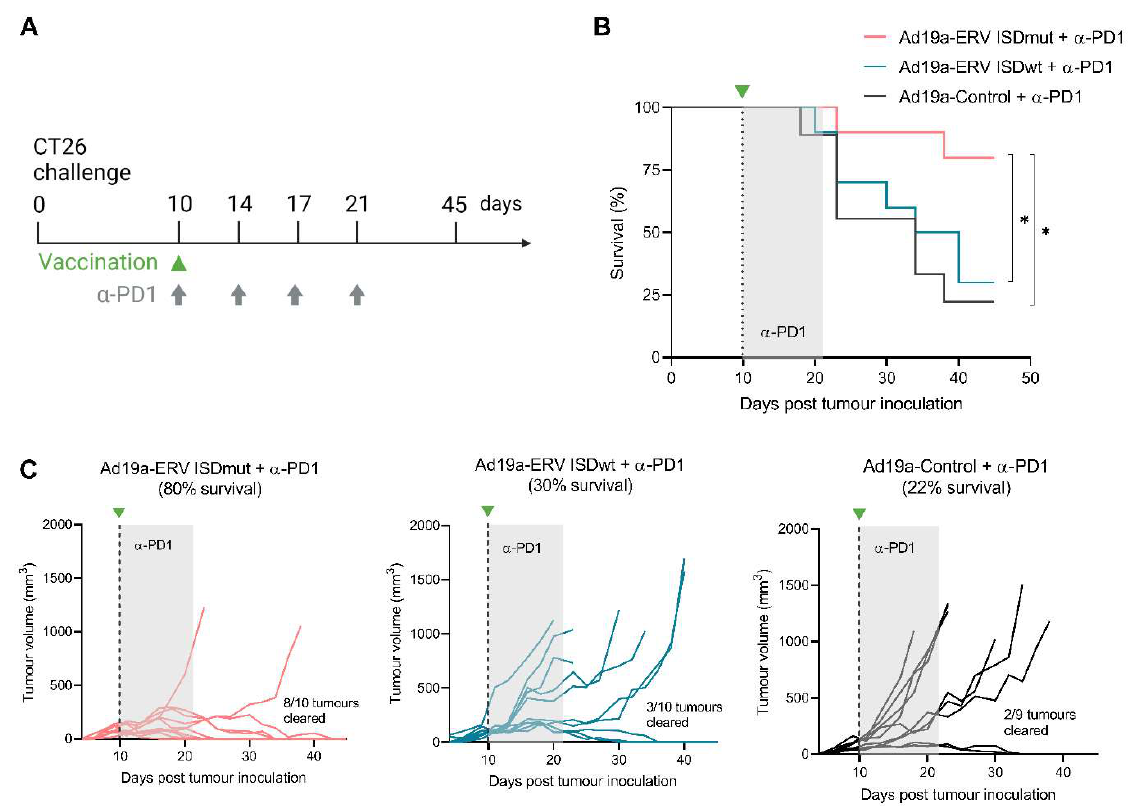
Figure 4. Ad19a/64-ERV ISDmut synergises with α -PD1 check point inhibitor and eradicates established colorectal tumours in mice . ( A ) Schematic representation of the tumour challenge and the therapeutic treatment. BALB/c mice were challenged s.c. (right flank) with 5 × 10 5 CT26 cells and tumour size was evaluated every 2–3 days. Mice were randomized and vaccinated s.c. (left paw) on day 10 with either the Ad19a/64-ERV ISDwt (blue), the Ad19a/64-ERV ISDmut (coral) or the Ad19a/64-Irrelevant (black) vaccine. α-PD1 treatment was administered i.p. concomitant to the vaccination, and then repeated three times every 3–4 days. ( B ) Fraction of surviving mice over time after CT26 challenge and treatment. ( C ) Tumour volume (mm 3 ) over time after challenge and treatment. N = 9–10, *: p < 0.05 —Log-rank (Mantel–Cox) test. Ad19a/64 is referred to as Ad19a in the figure.